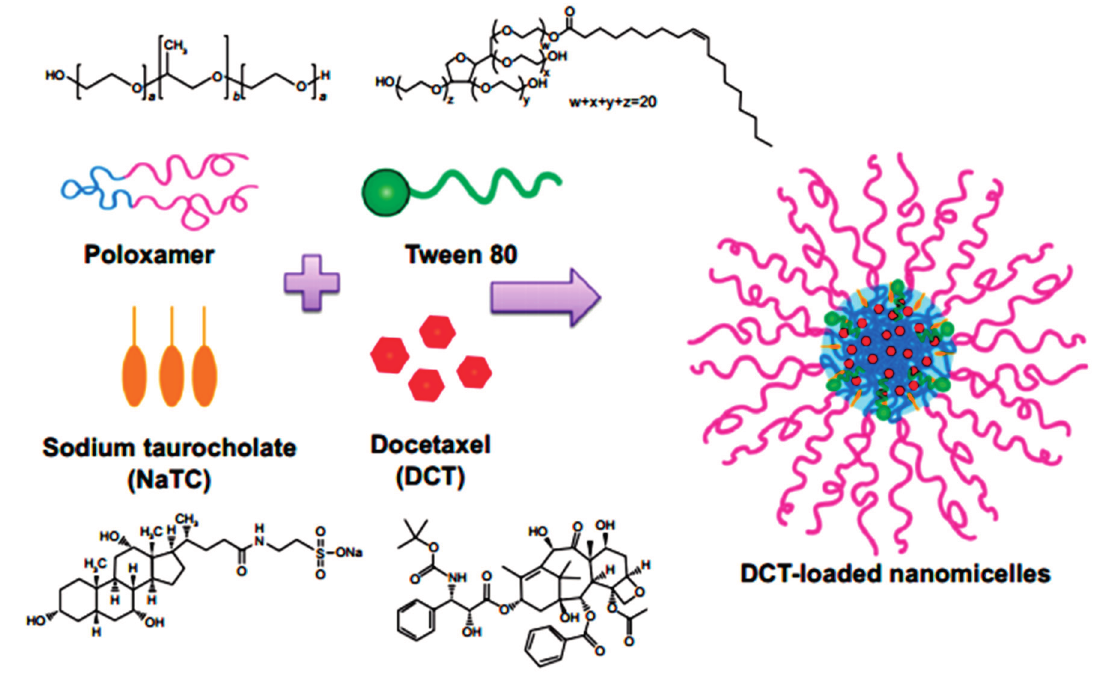
Figure 4. Preparation of DCT-loaded nanomicelles containing NaTC [88].